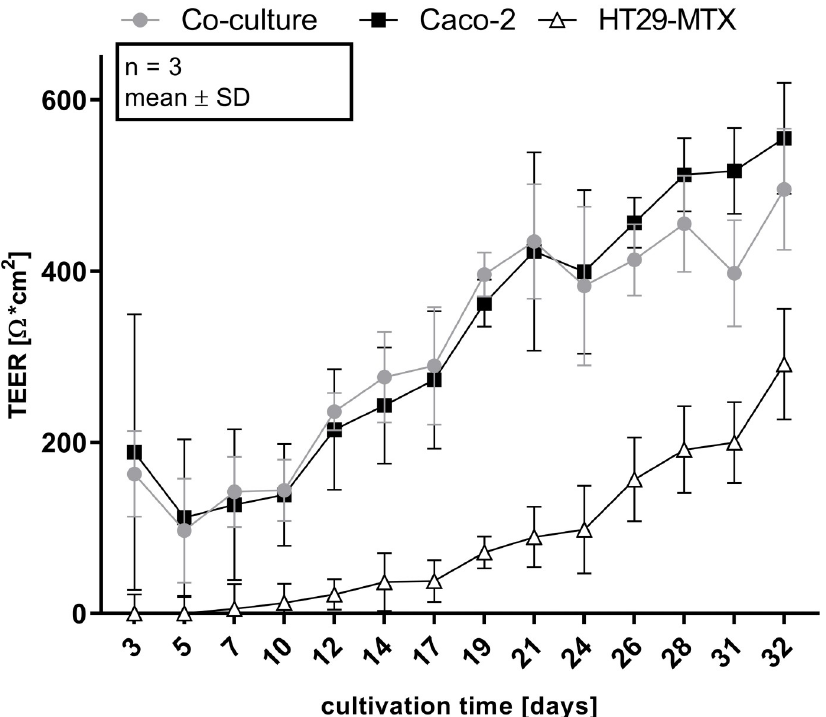
Fig 1. Changes of TEER values as a function of time of Caco-2, HT29-MTX and co-cultured Caco-2 and HT29-MTX cells incubated for 32 days on Snapwells 1 . Shown are values obtained from four experiments, each performed in